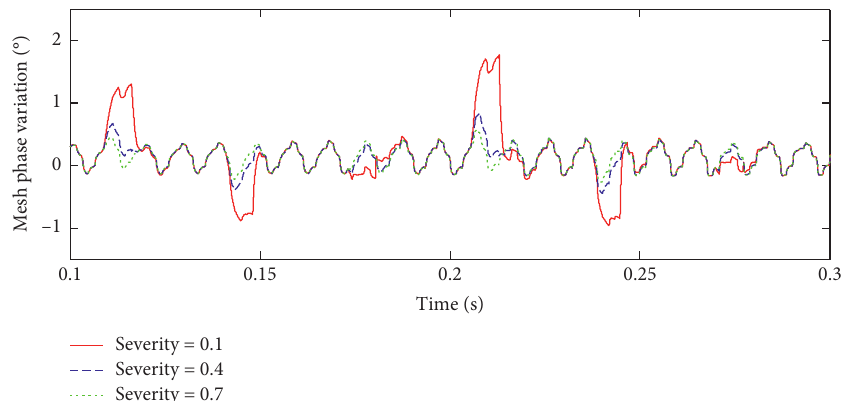
Figure 26: Meshing phase variation of s- p